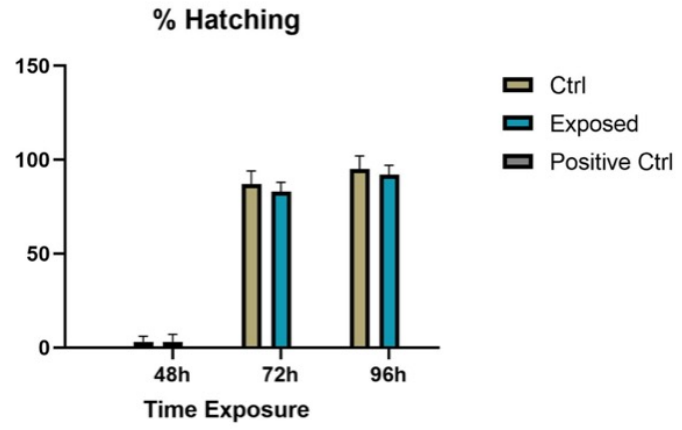
Figure 3. Hatching rates of controls, embryos exposed to 27 GHz, and positive control exposed to 3,4-DCA. There are no values at 24 h since no hatching occurred physiologically at this stage. Instead, a statistically significant difference was observed for heart rate. Thanks to the DanioScope TM (Noldus) software, it was highlighted that the exposure to 27 GHz caused an increase in heart rate of the exposed embryos at 48 h compared to the control group, but this increase was no longer seen at 72 h and 96 h (shown in Figure 4), as supported by statistical analysis that was not significant. Heart rate variability is the most significant parameter for the study of cardiac function; in zebrafish, the heart rate is physiologically around 120–180 bpm, but its alteration is associated with cardiotoxicity